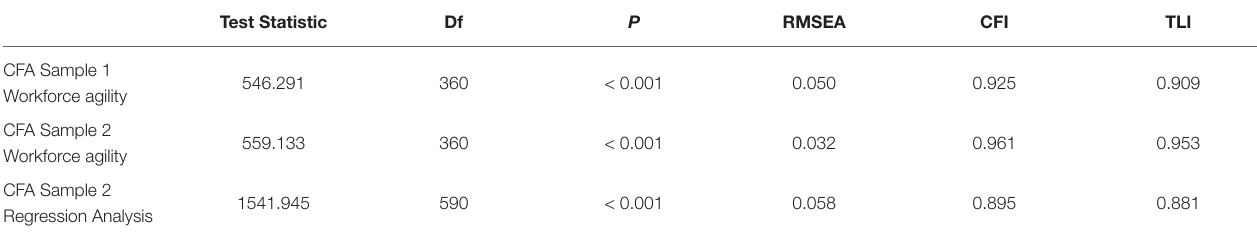
TABLE 7 | Model fits for the CFA with sample 1 and sample 2 and the regression analysis. Test